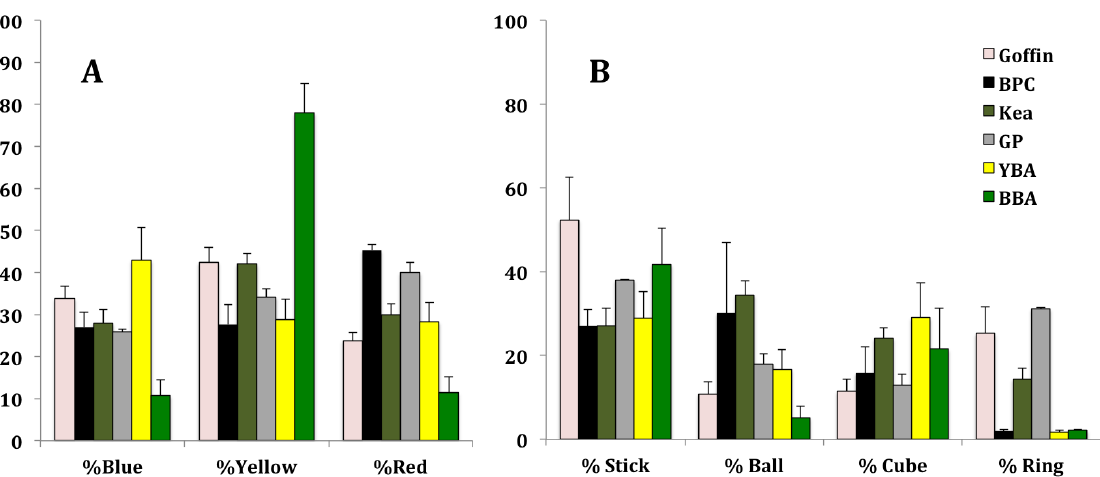
Appendix Figure S1. Mean percentage of object actions in which an object of a particular color (A: blue, yellow, red) or shape (B: stick, ball, cube, ring) was chosen. Goffin (N = 14), BPC (N = 2), kea (N = 14), GP (N = 10), YBA (N = 15), BBA (N =